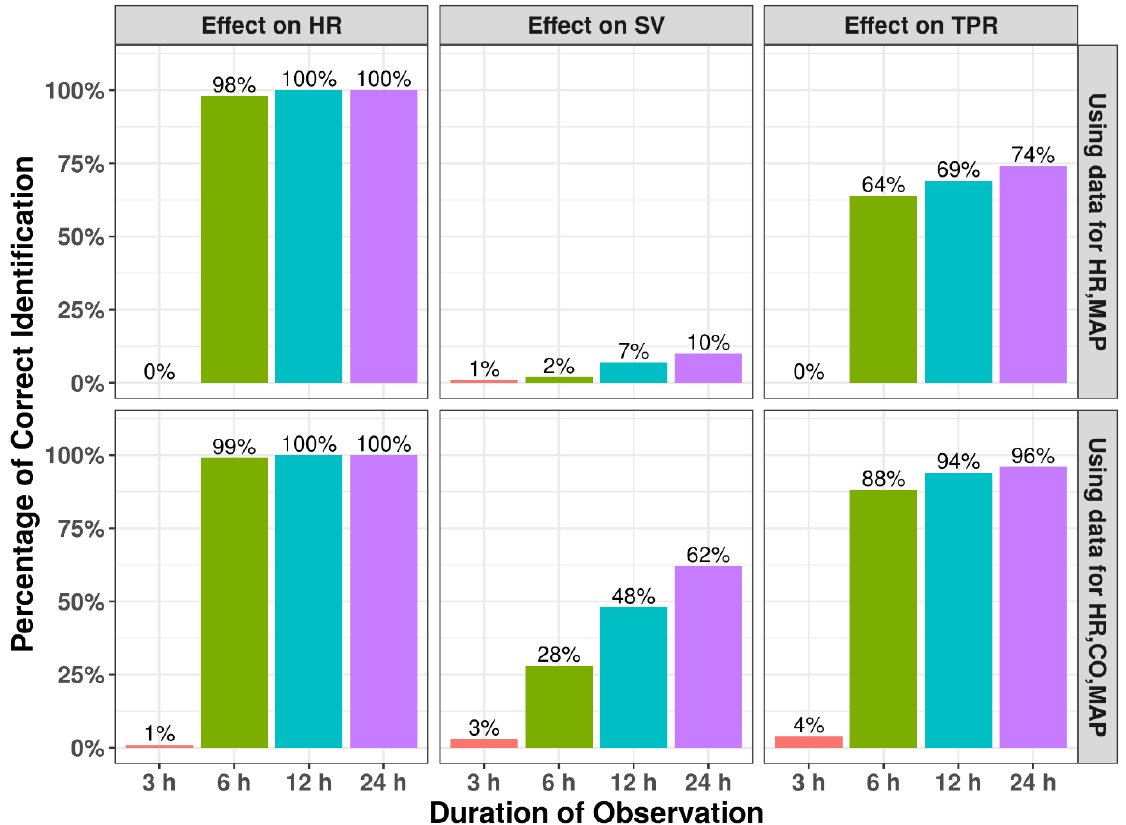
Figure 4. Impact of duration of experimental observations on the percentage of runs with correct identification of mechanisms of action. Results from simulation and re-estimation analyses using either observations of HR and MAP or observations of HR, CO, and MAP within 3 h, 6 h, 12 h, and 24 h. Emax was fixed as − 1 and EC 50 was fixed as 100 ug/mL in the original model. Emax was fixed to − 1 and EC 50 was fixed to 100 ug/mL in the original model. Correct identification is based on applying a likelihood ratio test compared to the base (no drug)